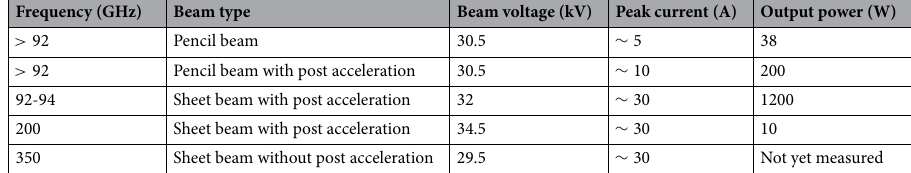
Table 1. The experimental results of the developed